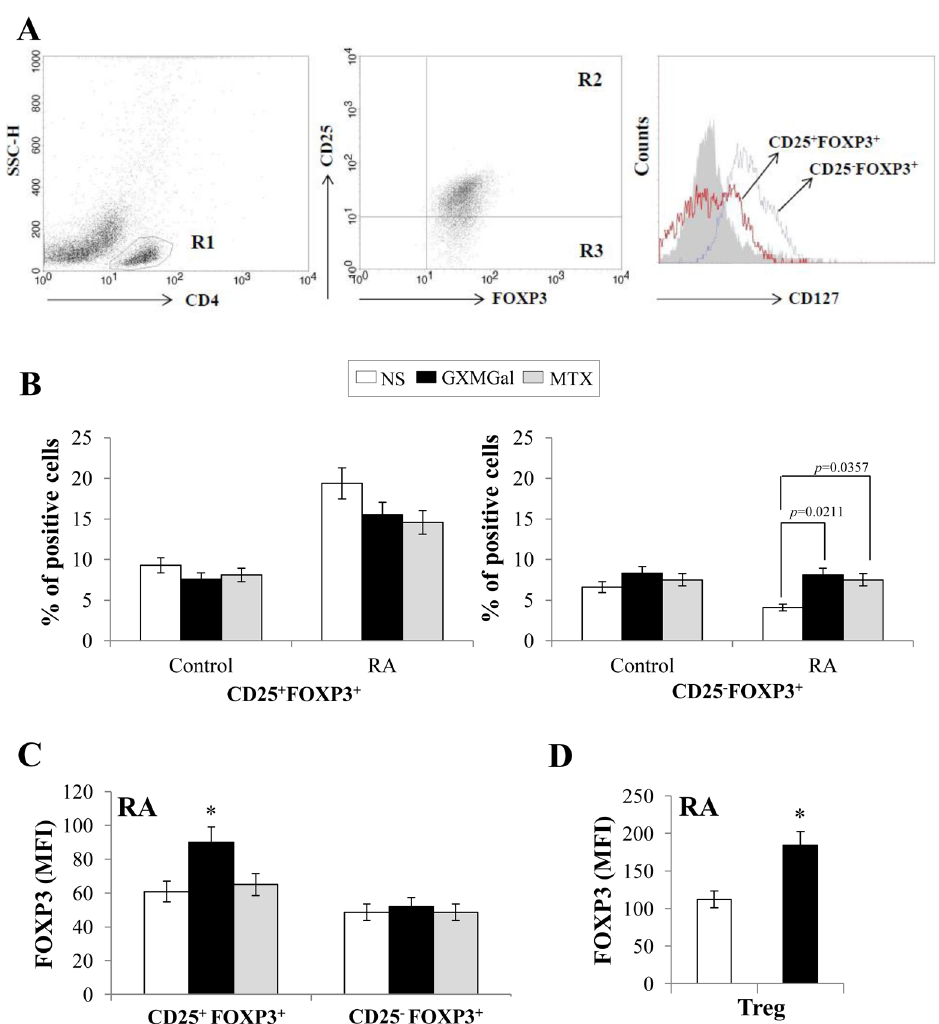
Figure 2. GXMGal effect on different subsets of Treg cells. Activated PBMC (1 6 10 6 /ml) from Control and RA were incubated for 2 h in the presence or absence (NS) of GXMGal (10 m g/ml) or MTX (10 ng/ml). After incubation, cells were stained for cell surface expression of CD4, CD25 and CD127 and then intracellular stained for FOXP3. During the acquisition step a population of PBMC enriched of CD4 + T cells was obtained. For analysis, the CD4 + lymphocytes were gated on PBMC (based on side light scatter and CD4 staining: R1) and analyzed for CD25 and FOXP3 expression (CD25 + FOXP3 + : R2 and CD25 2 FOXP3 + : R3). The expression of CD127 was shown as FACS histograms in R2 and R3 cells. The gating strategy was shown ( A ). The percentage of CD25 + FOXP3 + and CD25 2 FOXP3 + cells are shown as mean 6 SEM of ten independent experiments. p =0.0211 (triplicate samples of 10 different Control and RA; RA GXMGal-treated vs untreated cells); p =0.0357 (triplicate samples of 10 different Control and RA; RA MTX-treated vs untreated cells ( B ). The mean of fluorescence intensity (MFI) of FOXP3 in CD25 + FOXP3 + and CD25 2 FOXP3 + cells ( C ) or magnetically purified Treg ( D ) from RA after 18 h of GXMGal or MTX treatment was shown as mean 6 SEM of five independent experiments. *, p , 0.05 (triplicate samples of 5 different RA; RA GXMGal-treated vs untreated